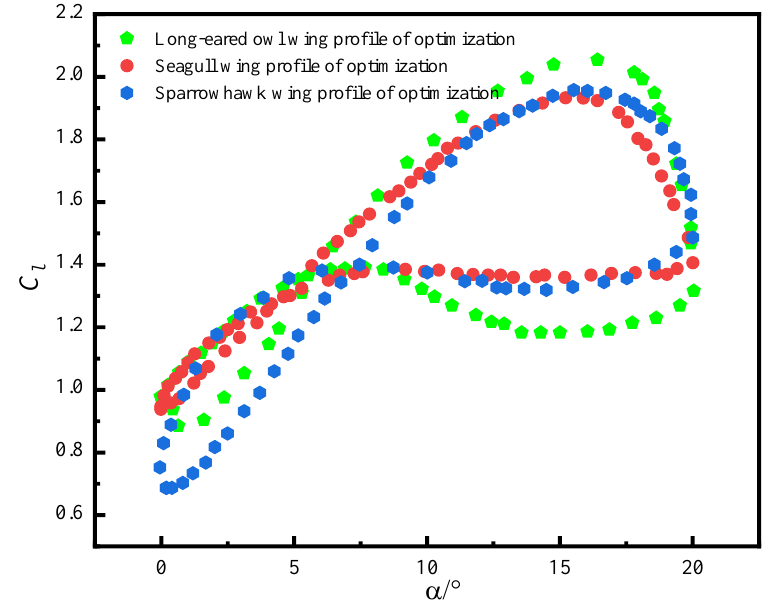
Figure 15. Dynamic lift coefficient.